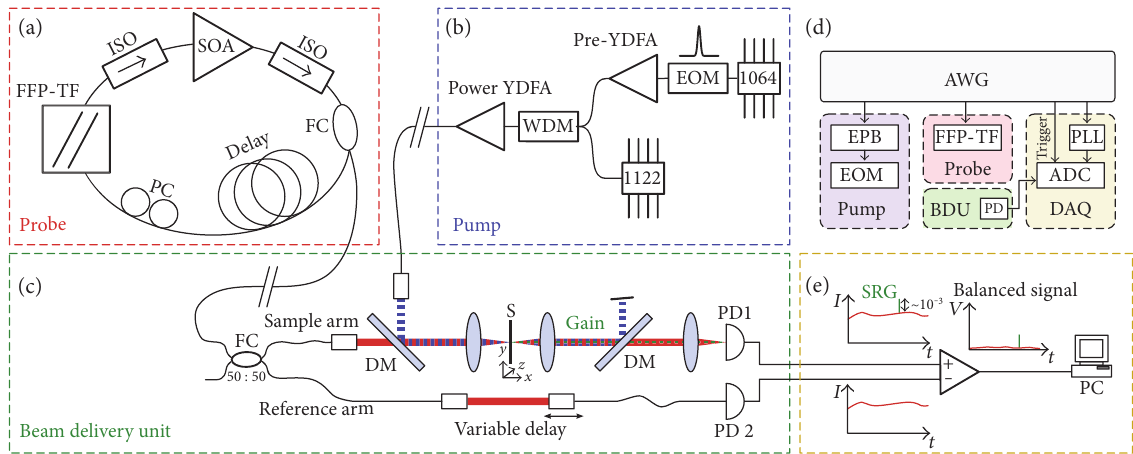
Figure 1: The schematic of the shot-noise limited TICO-Raman spectroscopy system is presented. (a) The FDML probe laser comprises a fi ber Fabry-Pérot tunable fi lter (FFP-TF), optical isolators (ISO) for unidirectional lasing, a semiconductor optical ampli fi er (SOA), a fi ber-coupler (FC) output, a resonant time delay, and a polarization controller (PC) paddle. (b) The pump laser is a home-built master oscillator fi ber power ampli fi er (MOFPA) with additional Raman shifter. It consists of a narrow-line laser diode at 1064nm, followed by a fast electro-optical amplitude modulator (EOM). This EOM is used to digitally modulate the TICO pulse pattern and to adjust the pulse length to the detection bandwidth. The pulses are ampli fi ed by ytterbium-doped fi ber ampli fi ers (YDFA). A wavelength-division multiplexer (WDM) can be used to couple in additional 1122nm seed light for Raman shifting inside the double-clad YDFA power ampli fi er. (c) The pump and probe lasers are collimated and combined by dichroic mirrors (DM) before being focused onto the Raman active sample (S). After recollimation, the pump light is blocked by additional dichroic fi lters and detected on a photodiode (PD1). A second photodiode (PD2) is used to detect reference light for di ff erential, balanced detection. (e) The di ff erential transimpedance ampli fi er subtracts FDML o ff set light and common mode noise, so only intensity changes induced in the Raman-active sample are digitized by the data acquisition (DAQ). (d) The whole system is synchronized by an arbitrary waveform generator